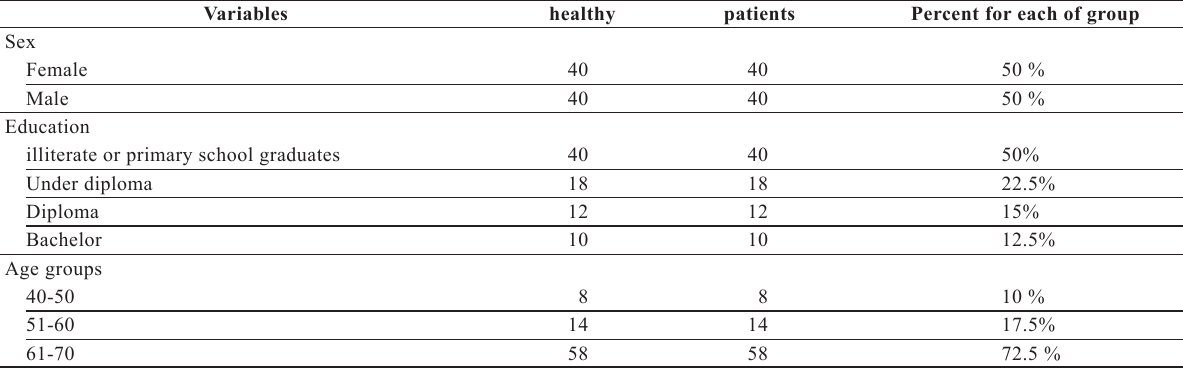
Table 1. Demographics of patients with PD and healthy